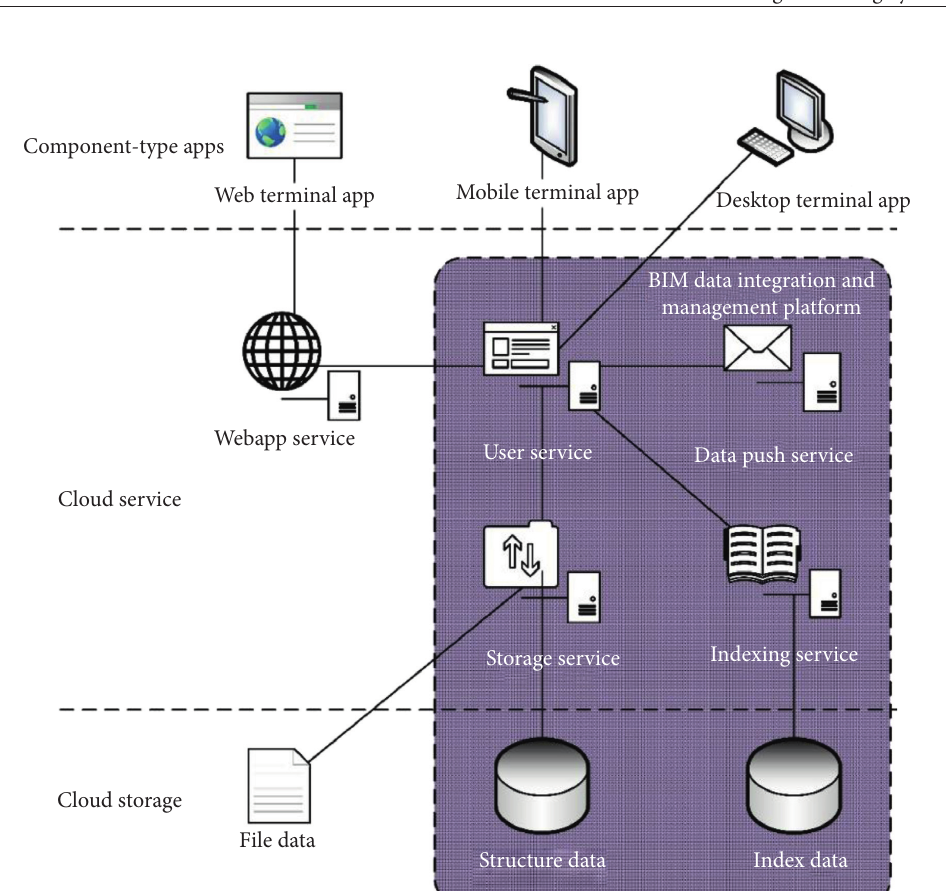
Figure 1: Cloud-based BIM O&M database.